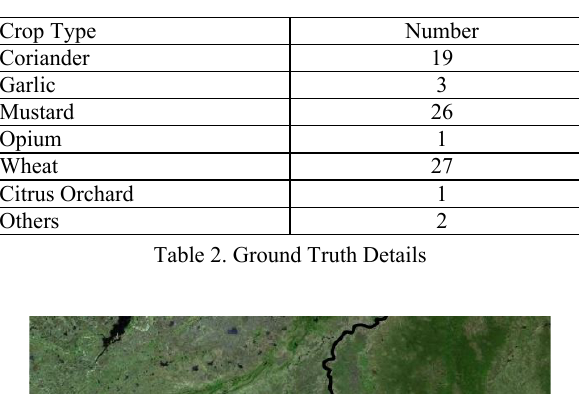
Figure 1. State wise a) area; b) production of coriander in the country, and district wise c) area; d) production in Rajasthan